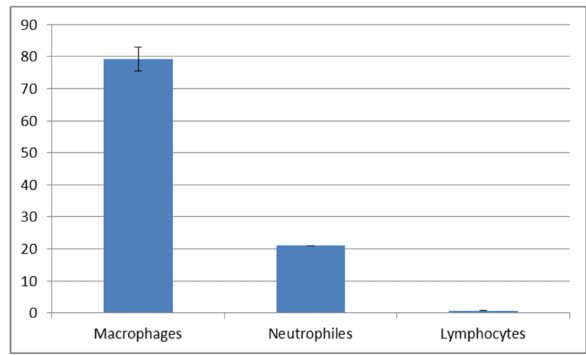
Figure 10. Percentage share of immune cells in the spring-summer mucus.